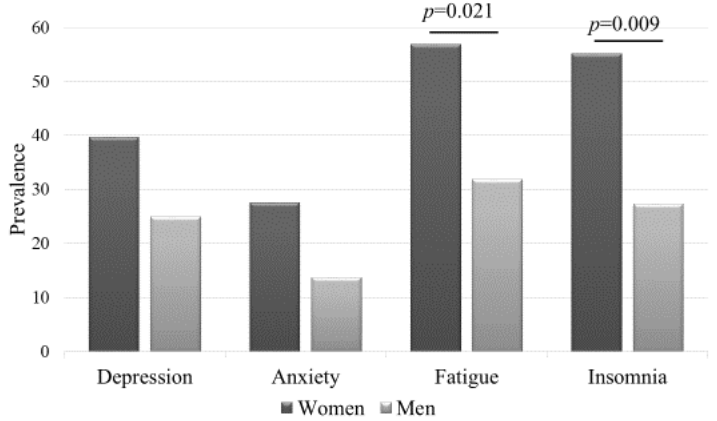
Figure 1. The prevalence of symptoms of depression, anxiety, fatigue, and insomnia in different gender groups.